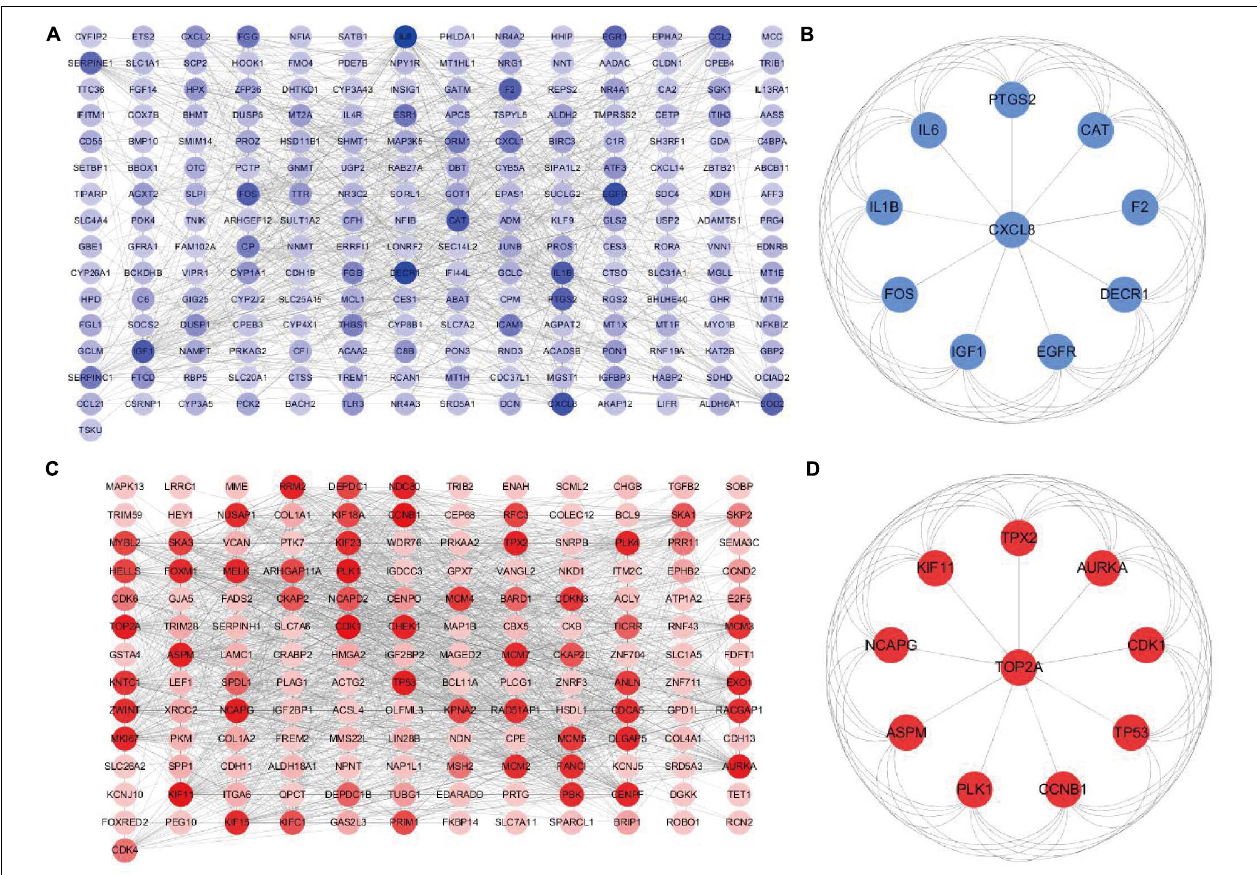
FIGURE 6 | Construction of PPI network based on downregulated or upregulated candidate genes. PPI network of (A) downregulated or (B) upregulated candidate genes. (C) The top 10 hub genes of downregulated candidate genes based on the node degree. (D) The top 10 hub genes of upregulated candidate genes based on the node degree. PPI, protein–protein